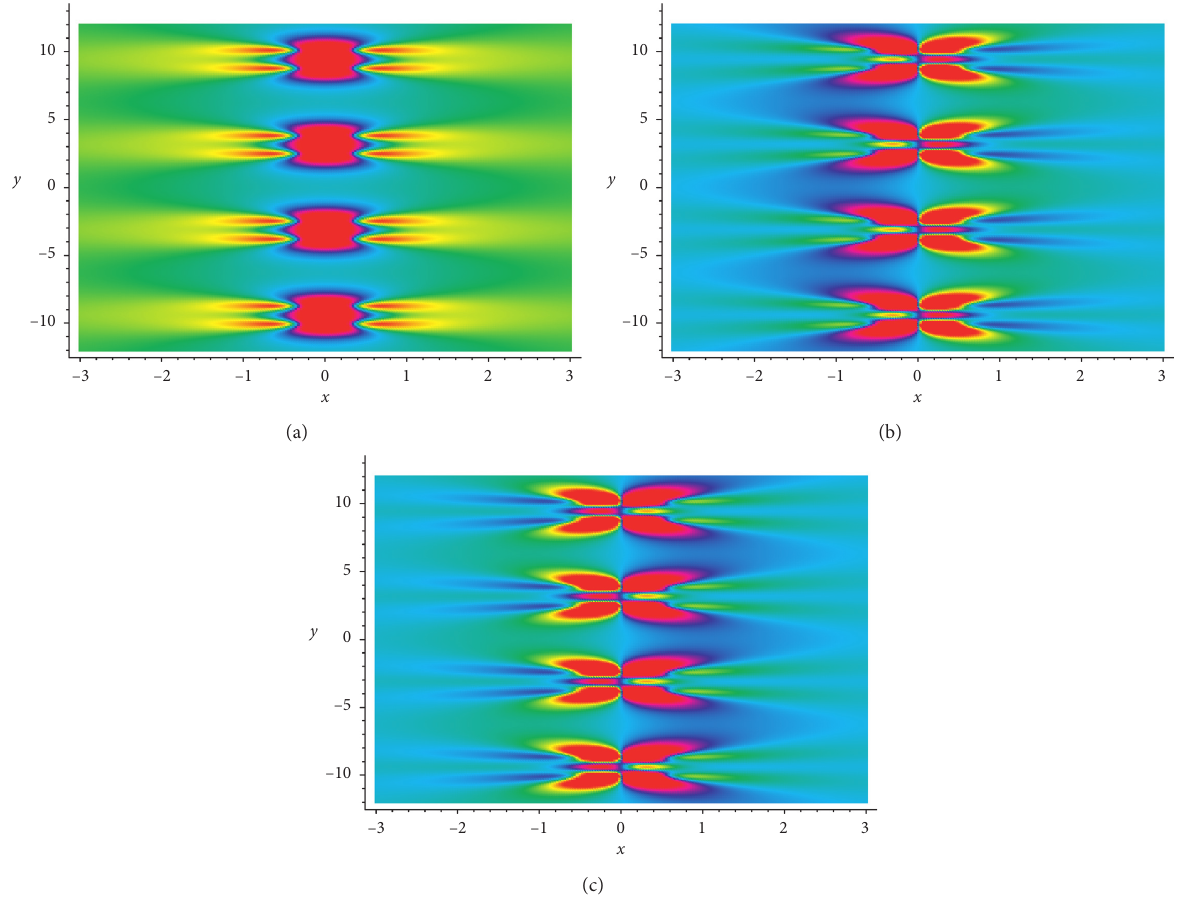
Figure 5: The y -periodic symmetry breaking density plot of the second-order breathers of the AB-KP systems (7a) and (7b), with the selected parameters b